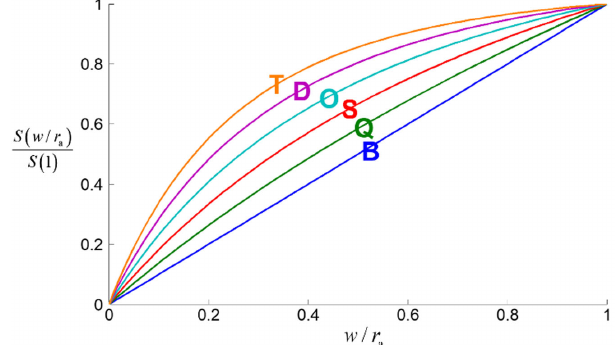
FIG. 3. Normalized strength versus w=r without iron screen with different number of poles (BQSODT: from dipole to